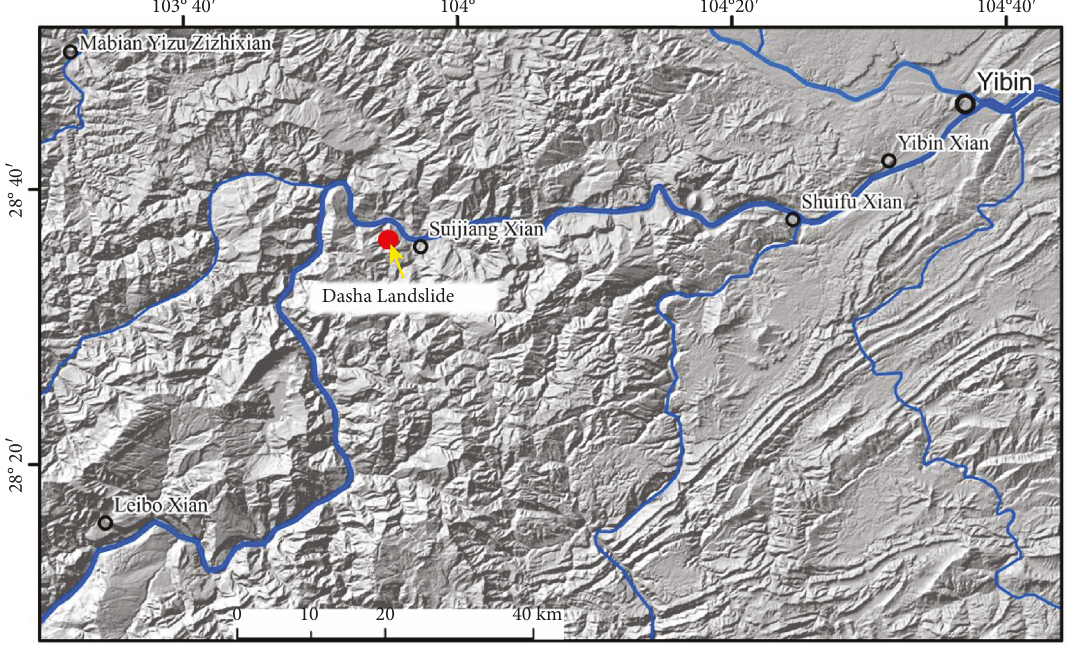
Figure 3: Location map of Dasha